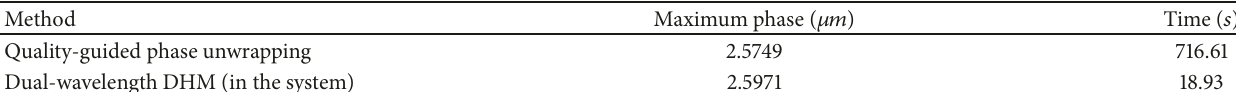
Table 1: Comparison of two methods.